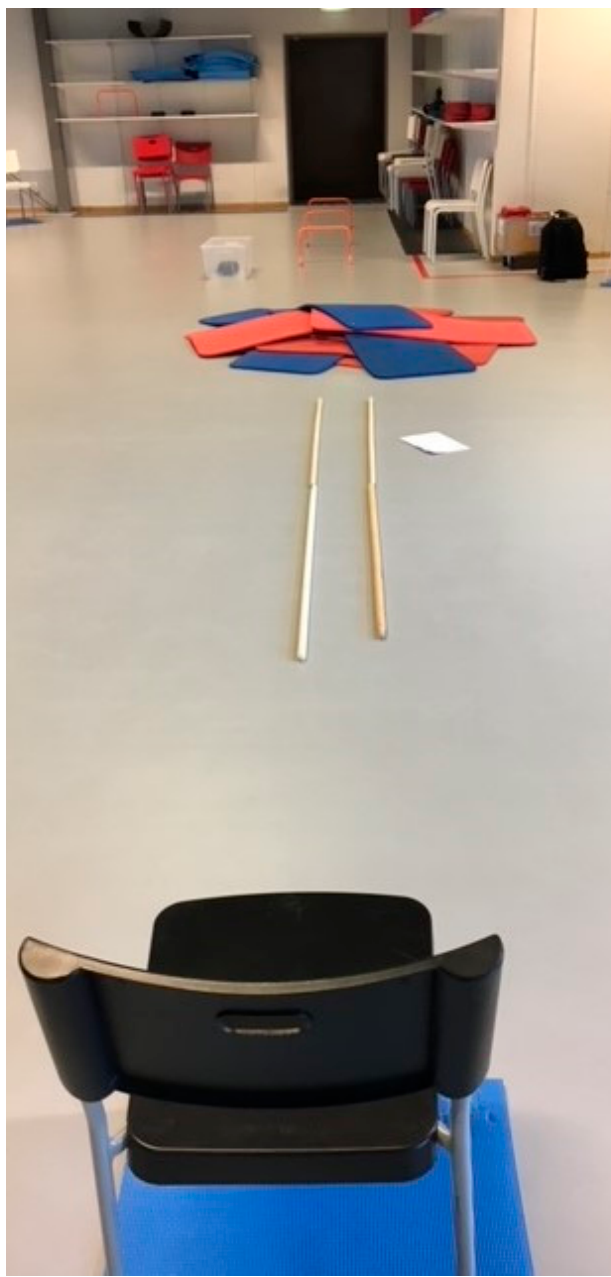
Figure 1. The obstacle course, including walking within a 25 cm narrow strip for 3 m, walking over an uneven surface, walking over three 30 cm high obstacles, walking up and down stairs with 10 steps (behind the door in the back of the picture), and walking back to the starting point.